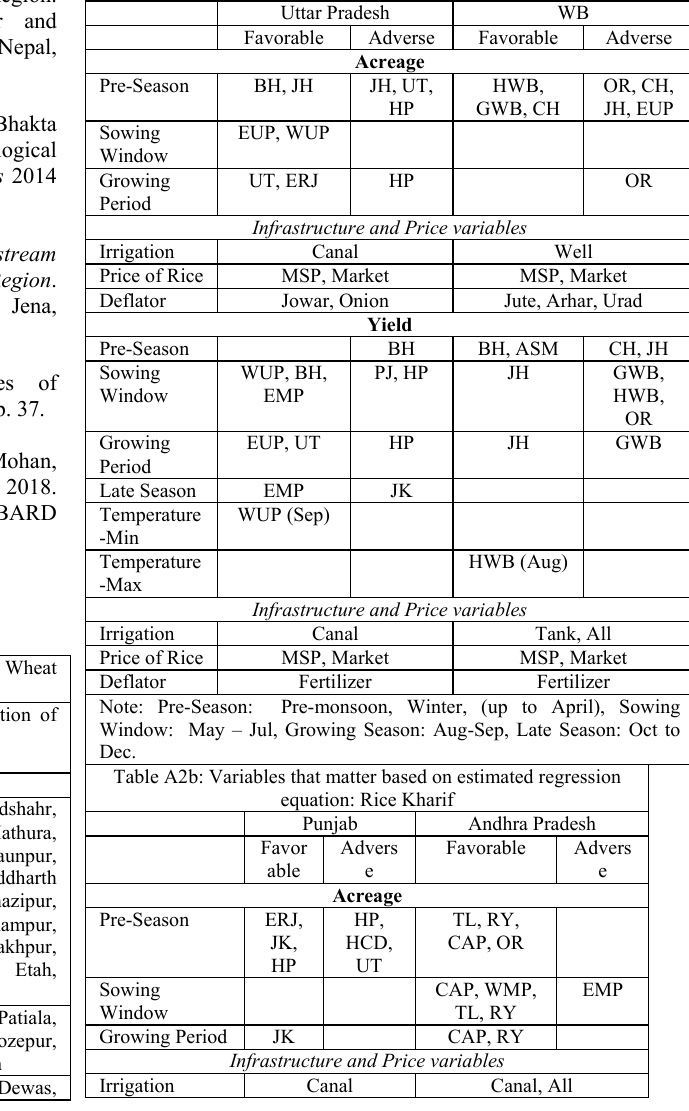
Table A2a: Variables that matter based on estimated regression equation: Rice Kharif Uttar Pradesh